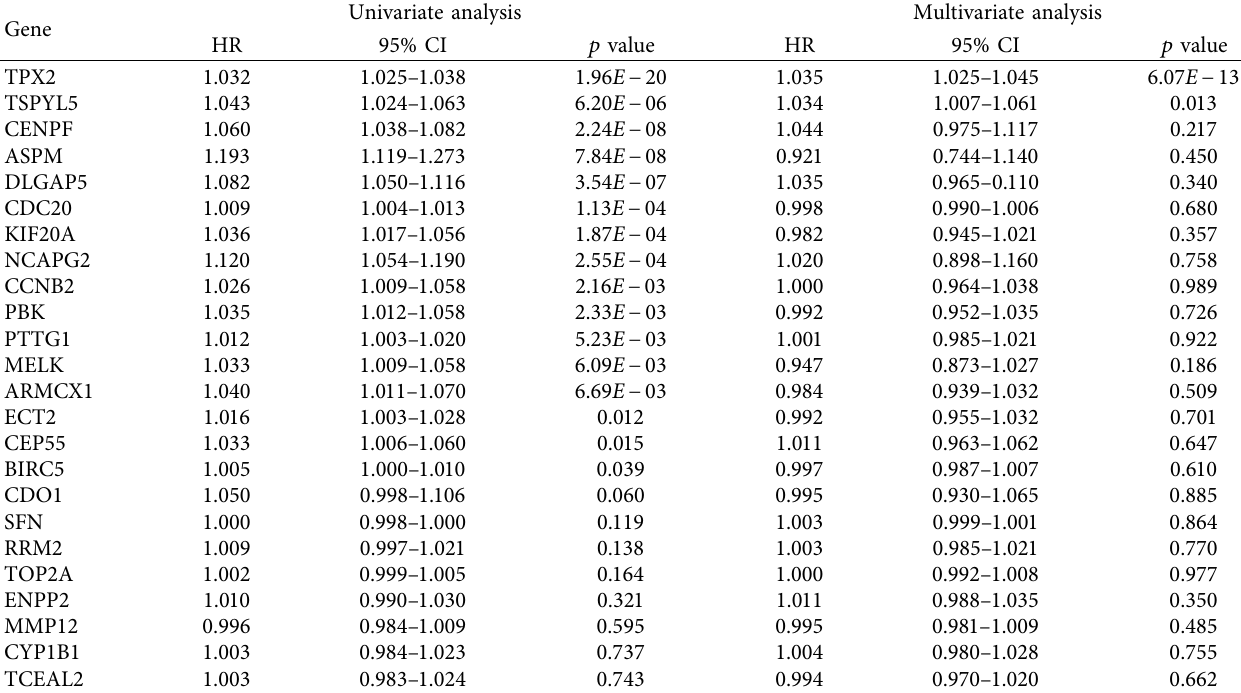
Table 1: Univariate/multivariate cox regression analysis for hub genes.